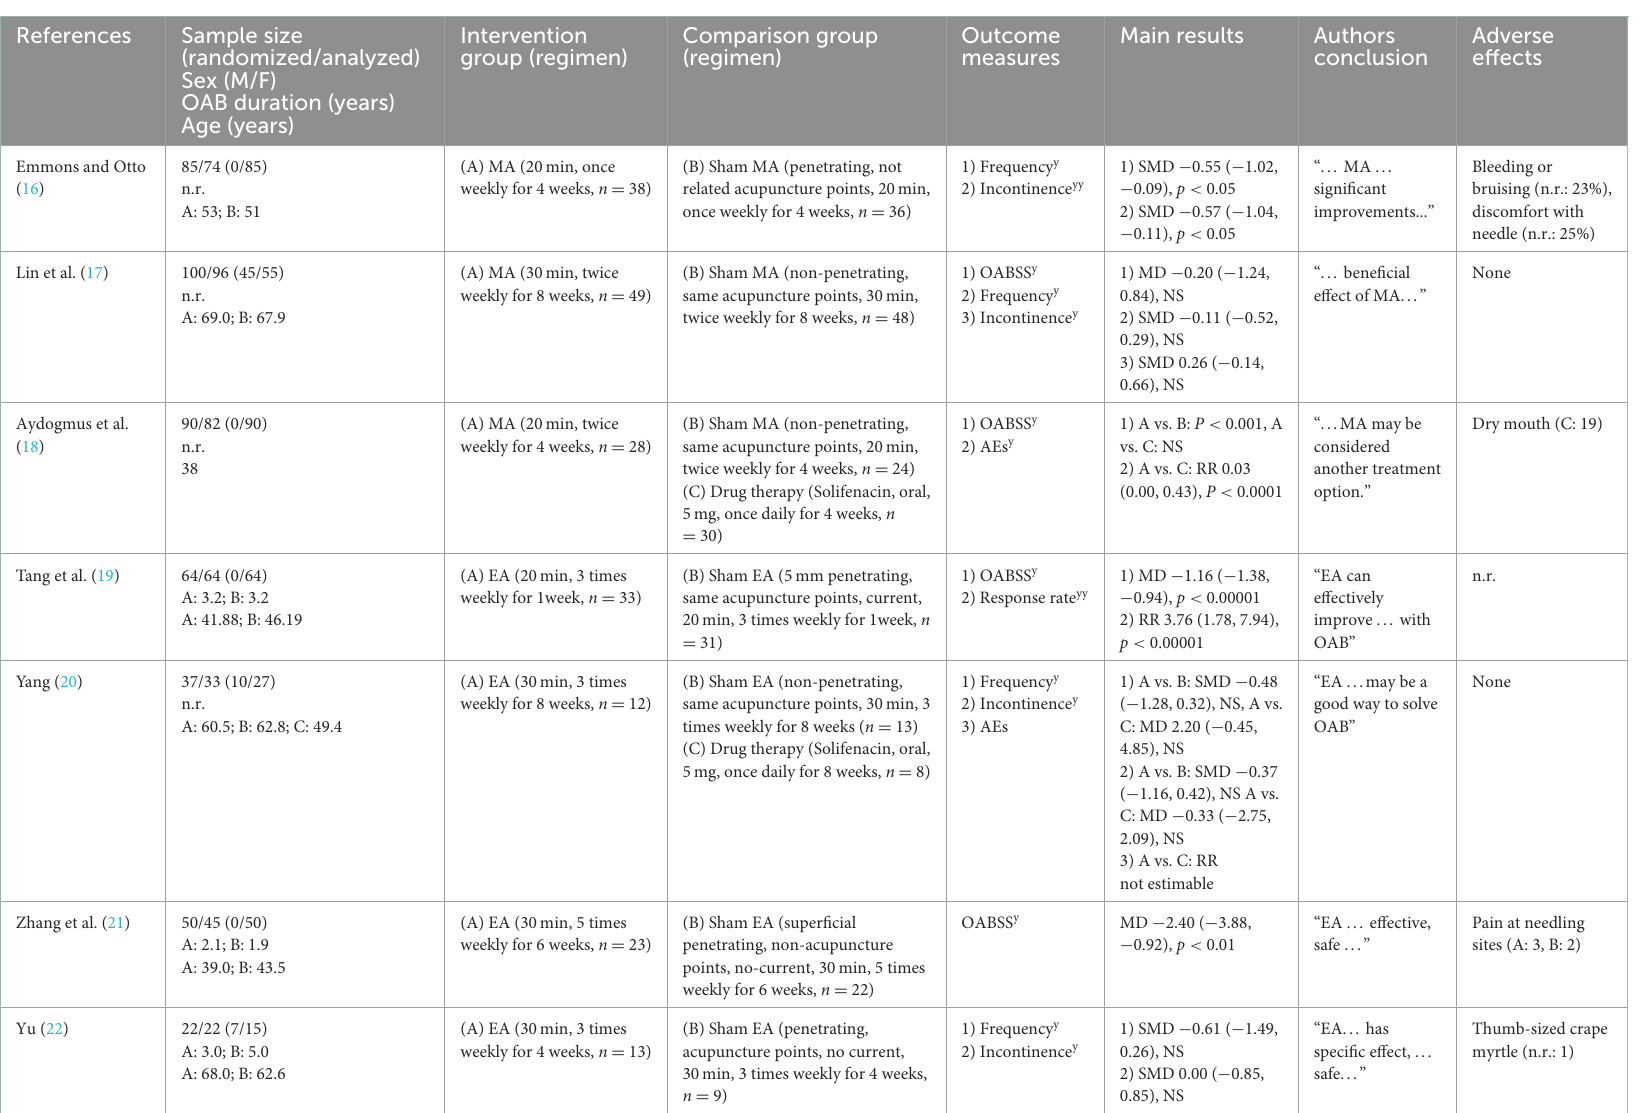
TABLE 1 Summary of the characteristics of the included